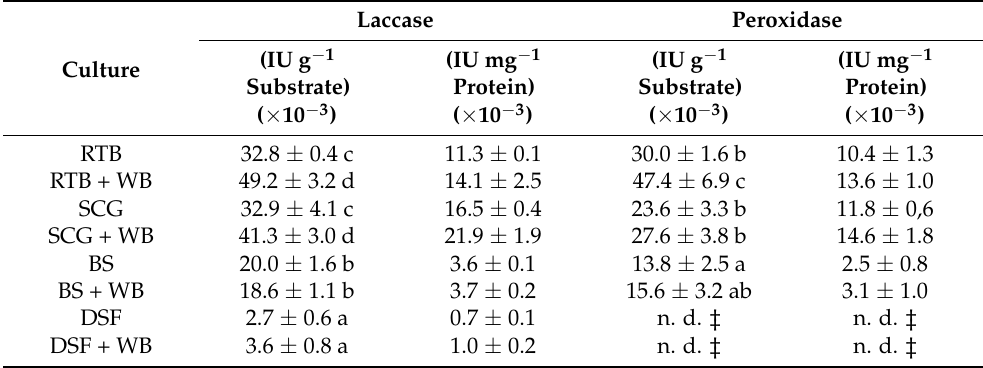
Table 6. Specific activities, referred to unit mass of the solid substrate and extracellular protein, of laccase and peroxidase in A. olivimuriae solid-state cultures conducted for 14 days at 301.15 K on residual thistle biomass (RTB), spent coffee rounds (SCG), barley straw (BS) e digestate solid fraction (DSF) in the absence and in the presence of wheat bran (WB). Data are the means ± standard deviation of 4 replicates. Multiple pair-wise comparisons were made with Tukey’s test, and identical letters denote that column means were not statistically different ( p > 0.05). Laccase Peroxidase (IU g − Culture